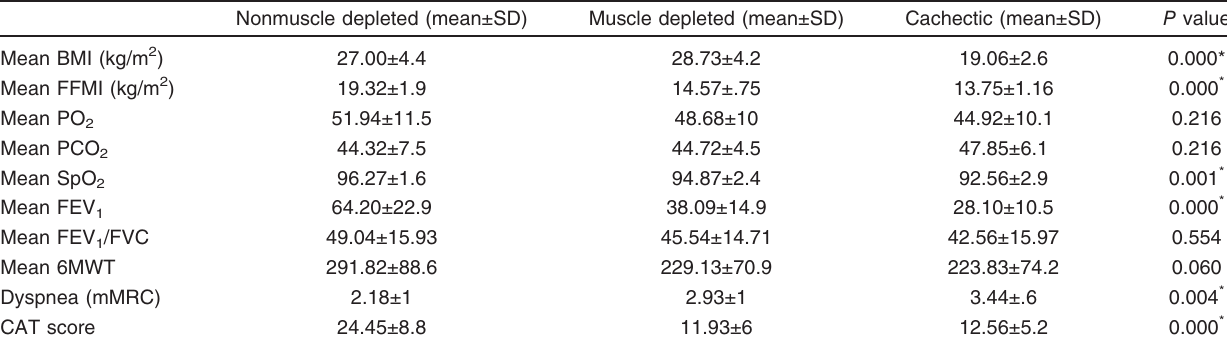
Table 5 Statistical comparison between non-muscle depleted, muscle depleted, and cachectic group before pulmonary rehabilitation program Nonmuscle depleted (mean±SD) Muscle depleted (mean±SD) Cachectic